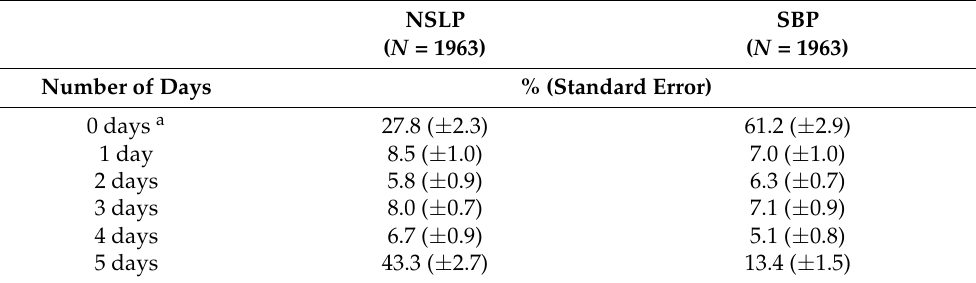
Table 1. Percentage of school-age children by participation status and meal